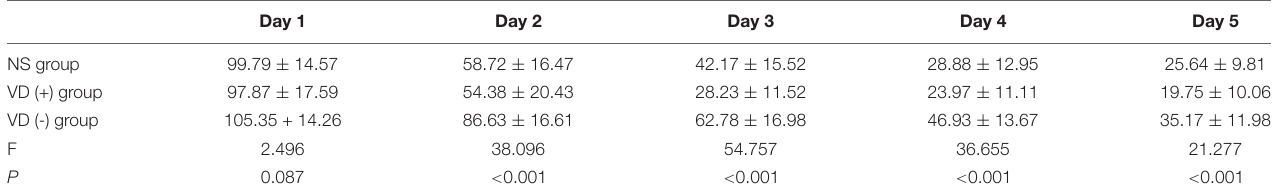
FIGURE 3 | Comparison of the results of the positioning navigation experiment between groups. TABLE 1 | One-way ANOVA for NS group, VD (+) group and VD (-)